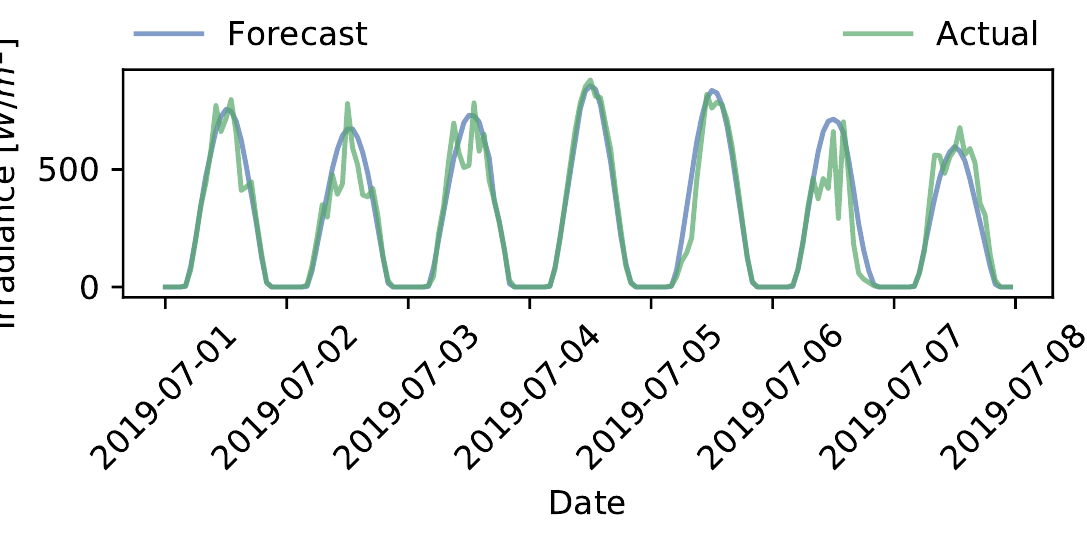
Figure 8. Comparison of forecasted and measured irradiance data during the first week of July